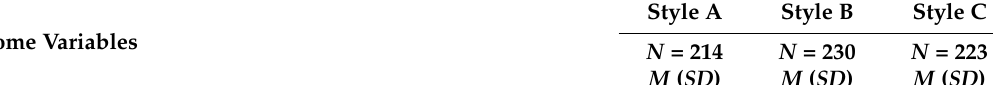
Table 4. Mean differences between the disclosure conditions in the seller/buyer study (willingness items sorted by mean willingness to adopt action within Study 2).